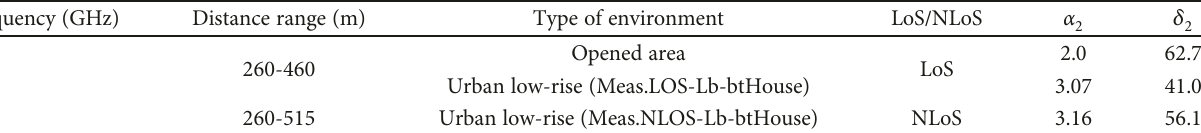
Table 2: Pathloss coe ffi cient on a path coming from inter-house space (at site-speci fi